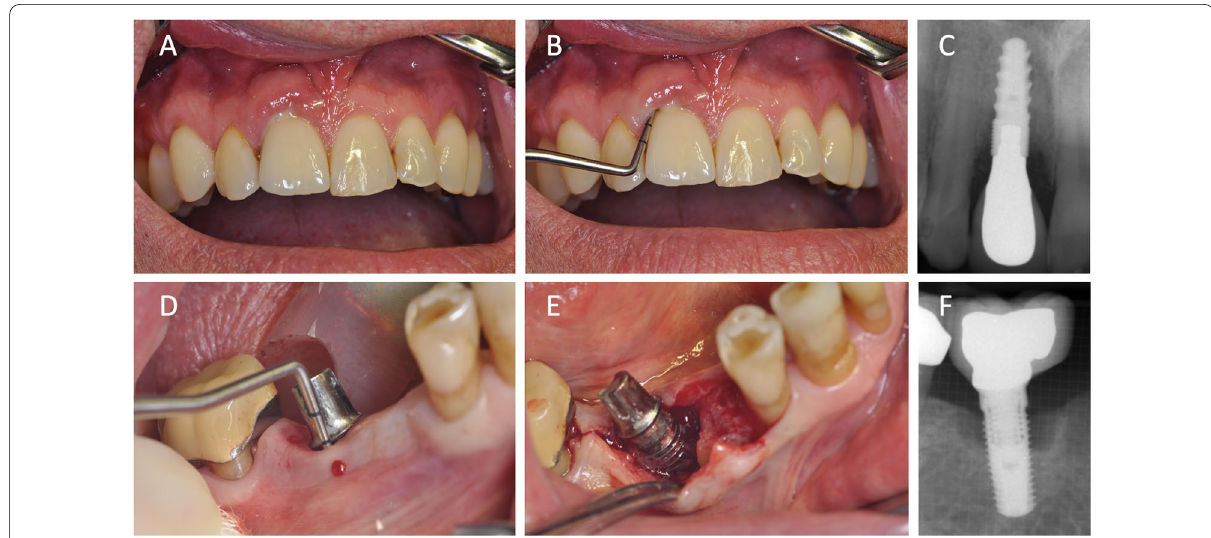
Fig. 4 Intraoral aspect of suspected intolerance/hypersensitivity to titanium implant placed in the upper incisor region in a patient without periodontal risk predisposition 2 years after implant insertion ( A and B ) and corresponding intraoral radiograph ( C ) and in the lower first molar region in a patient with genetic pro‑inflammatory predisposition 7 years after implant surgery ( D and E ) and corresponding intraoral radiograph ( F